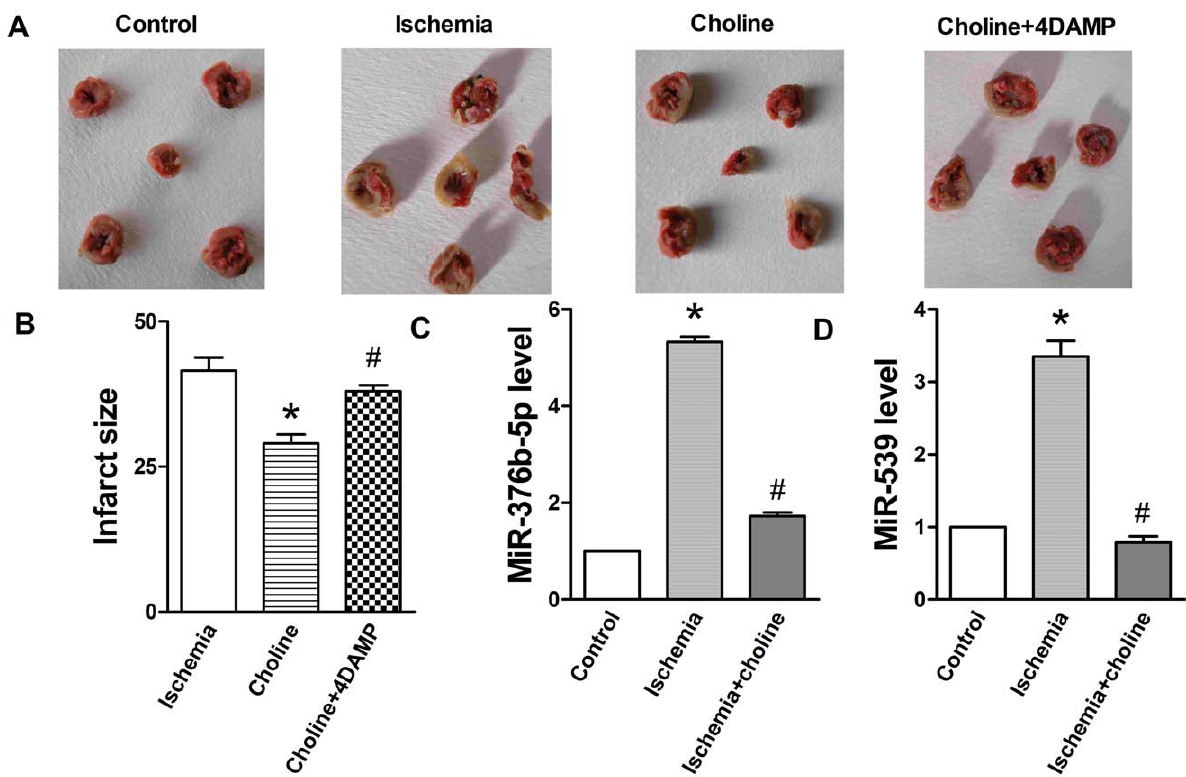
Figure 1. MiRNA is involved in M 3 -mAChR mediated cardioprotection against myocardial ischemia in rat. Choline (10 mg/kg, i.v.) was administrated 10 min before occlusion. 4DAMP (0.12 m g/kg) was administered 5 min before choline. (A) Representative infarct photographs. (B) Infarct size. Values were expressed as mean 6 SEM; n=8; * P , 0.05 vs. Control; # P , 0.05 vs. Choline. (C) Choline reversed ischemia-induced miR-376b- 5p up-regulation. (D) Choline reversed ischemia-induced miR-539 up-regulation. Values were expressed as mean 6 SEM; n=3; * P , 0.05 vs. Control, # P , 0.05 vs. Ischemia.